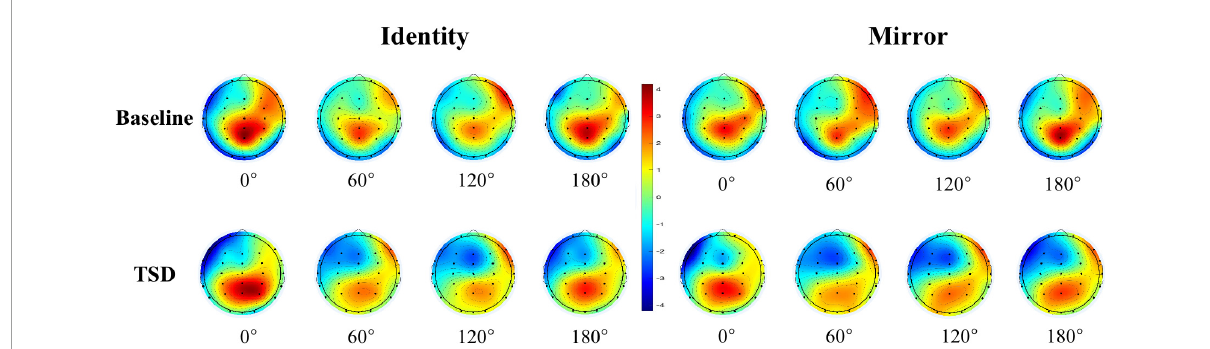
FIGURE3 EEG topographic map of mental rotation tasks on the Pz electrode under different sleep conditions (baseline and TSD).